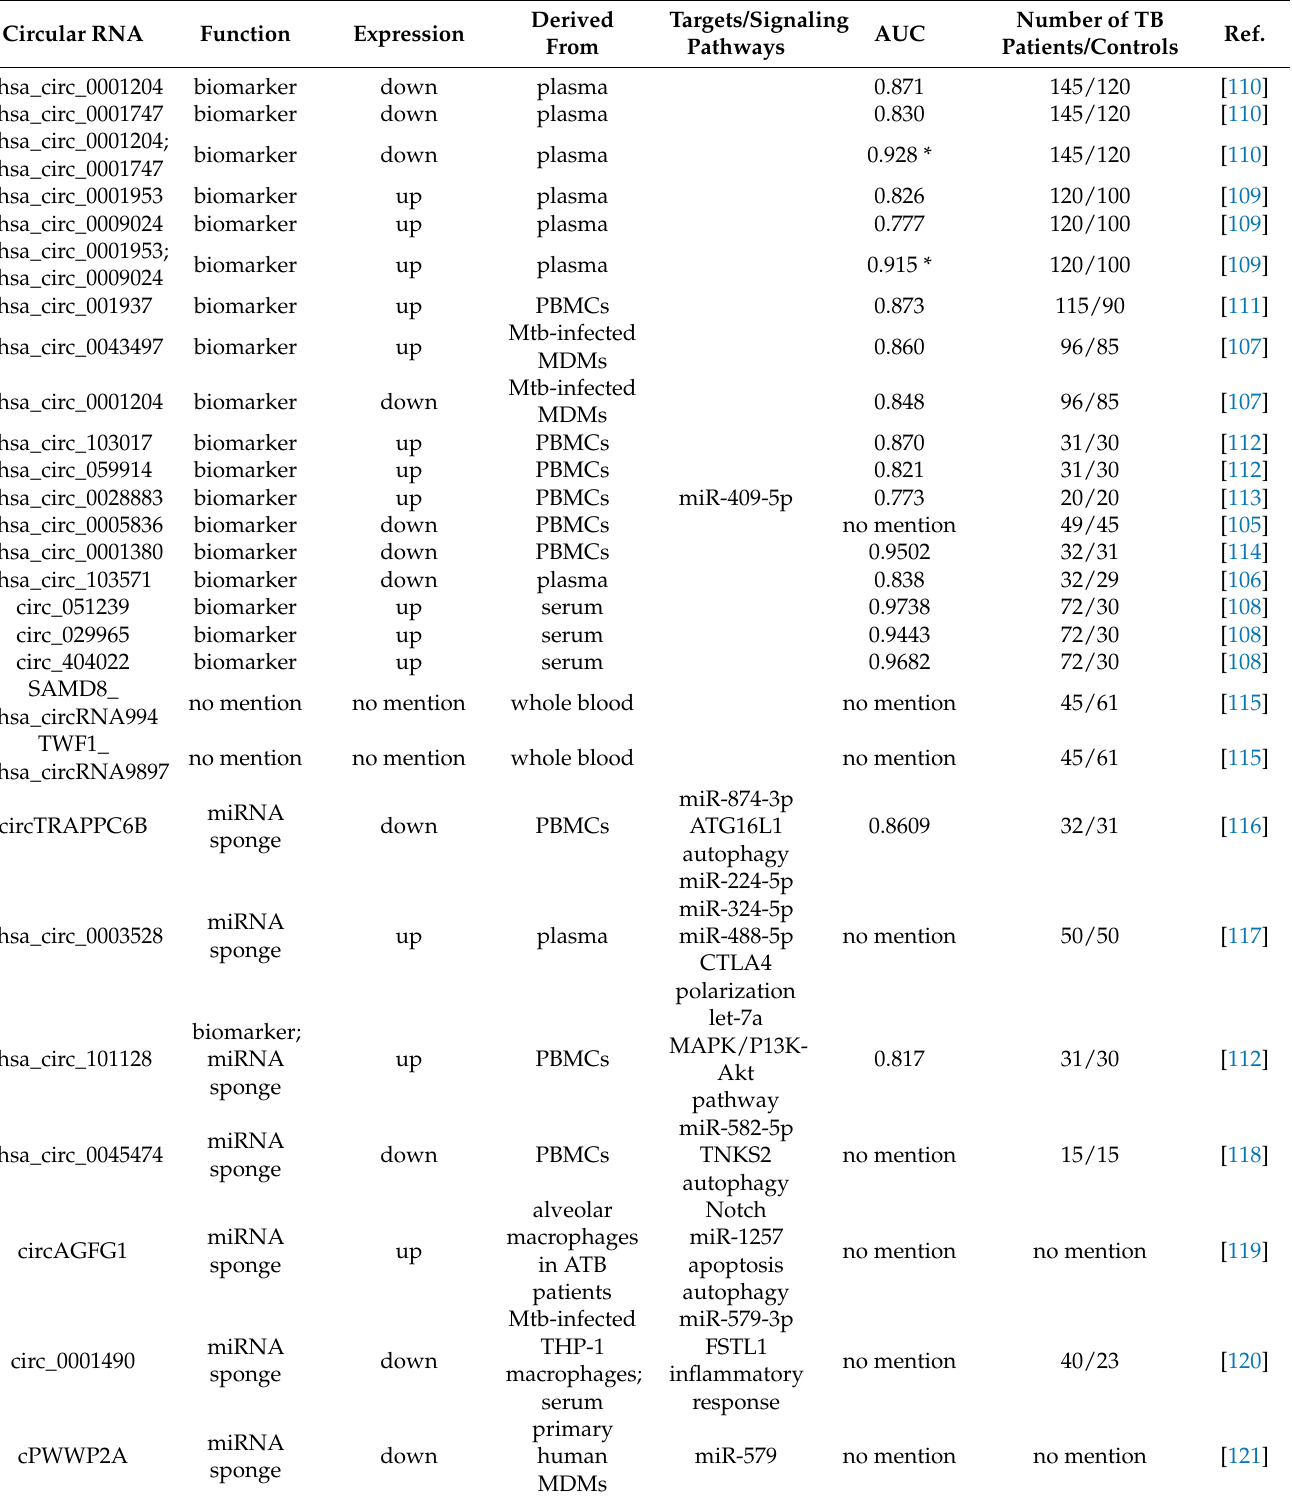
Table 1. Summary of all the circular RNAs that are currently reported to be involved in regulating Tuberculosis. Circular